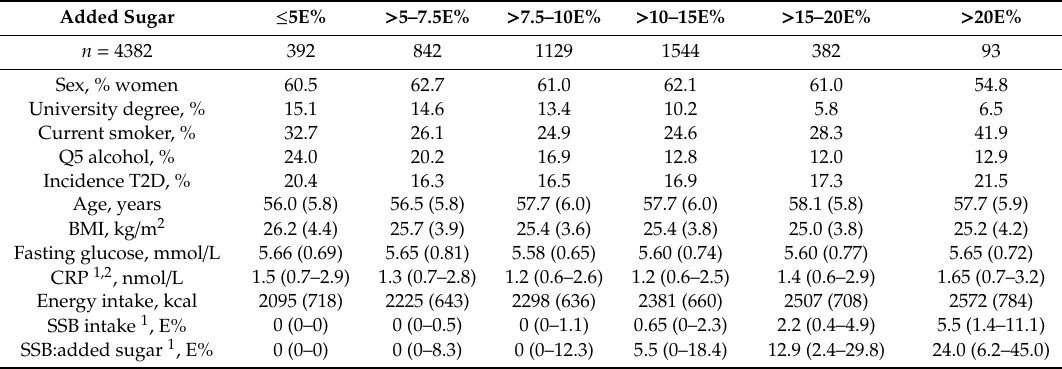
Table 1. Baseline characteristics of study participants across six categories of added sugar intake.